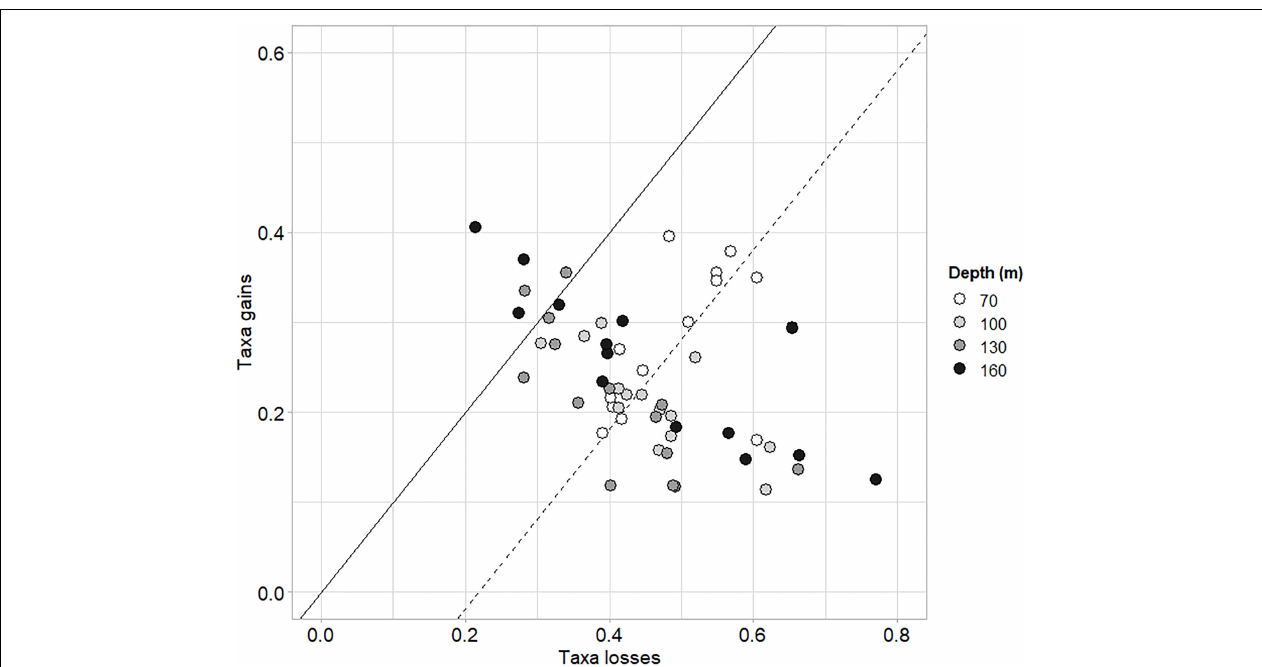
FIGURE 3 | Losses and gains of taxa between the samplings of 1990 and 2014. Gray shades indicate stations depth. The solid line represents the theoretical positions of samples where gains equal losses. The dashed line parallel to the black line passes through the centroid of all samples. Its position below the solid line indicates that, on average, taxa losses dominated gains from 1990 to